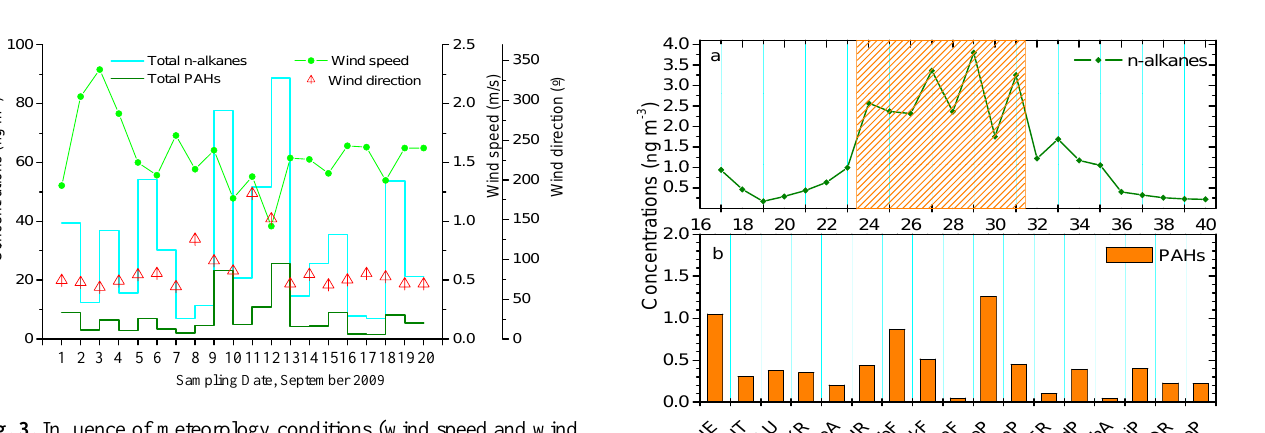
Fig. 3. Influence of meteorology conditions (wind speed and wind direction) on n -alkanes and PAHs concentrations.